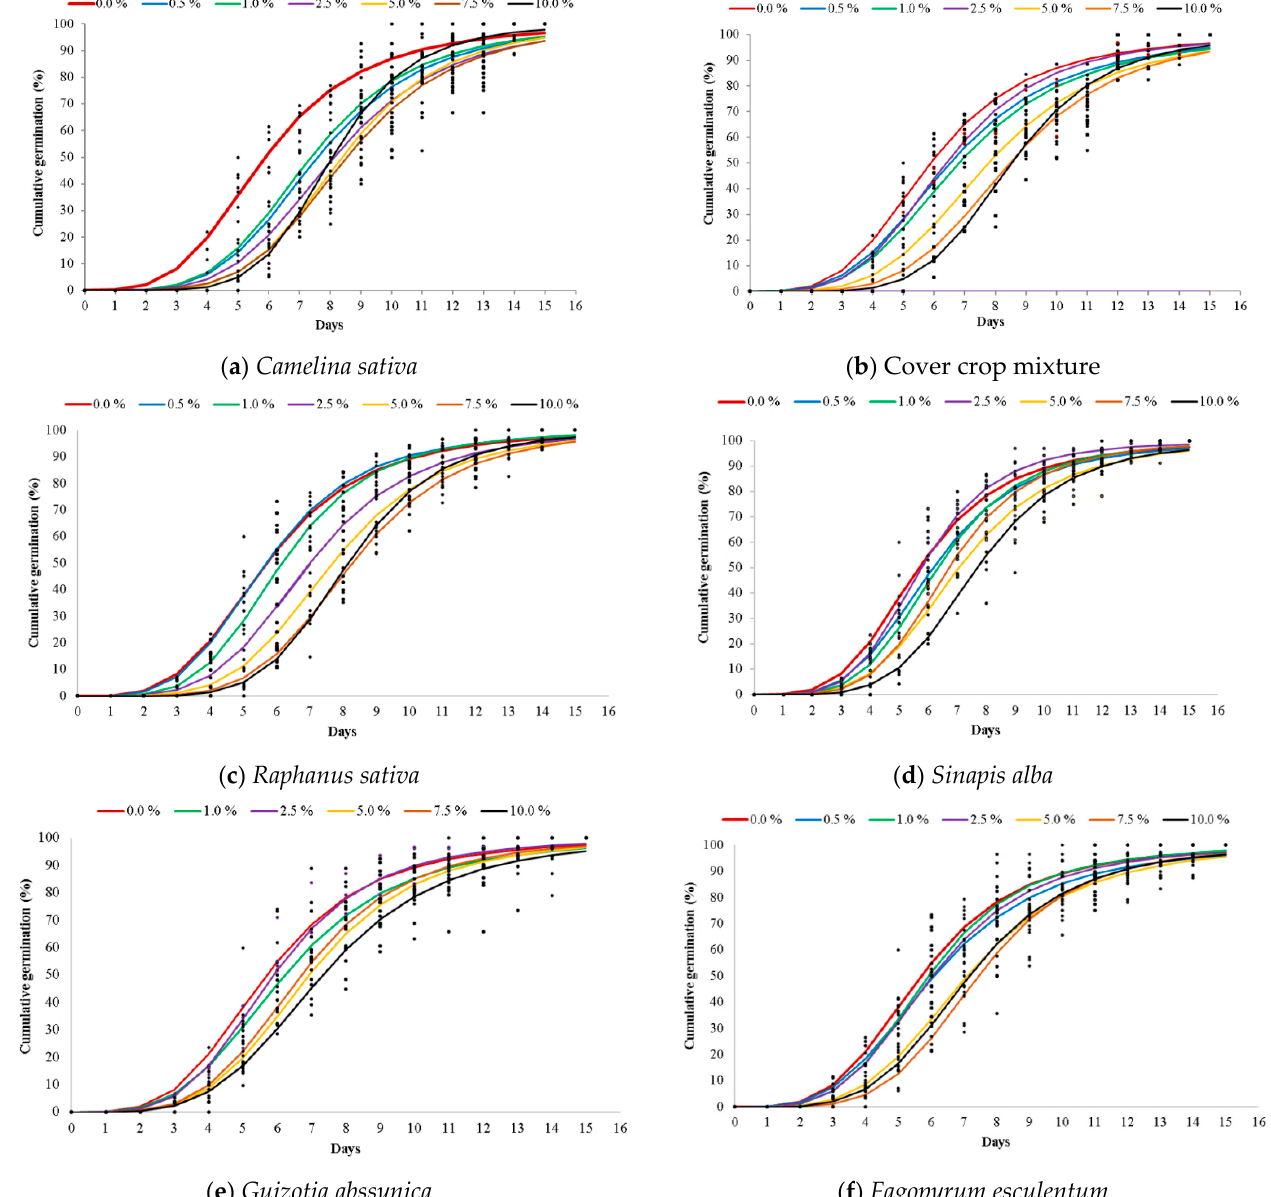
Figure A1. The germination rate of A. artemisiifolia upon the aqueous extracts of CCs. The cumulative germination was analyzed using a logistic function in the Bioassay97 statistical program (Onofri 2001), obtaining germination time course under different concentrations of aqueous extracts. The solid line represents the fitted model, and the dots represent observed germination. Within each CC aqueous extract, the same line color the concentrations of aqueous extract (0%–10%).